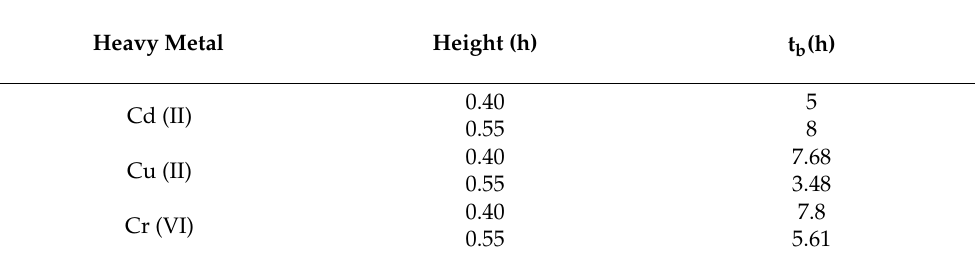
Table 9. t b varying height for Cd (II), Cu (II) and Cr